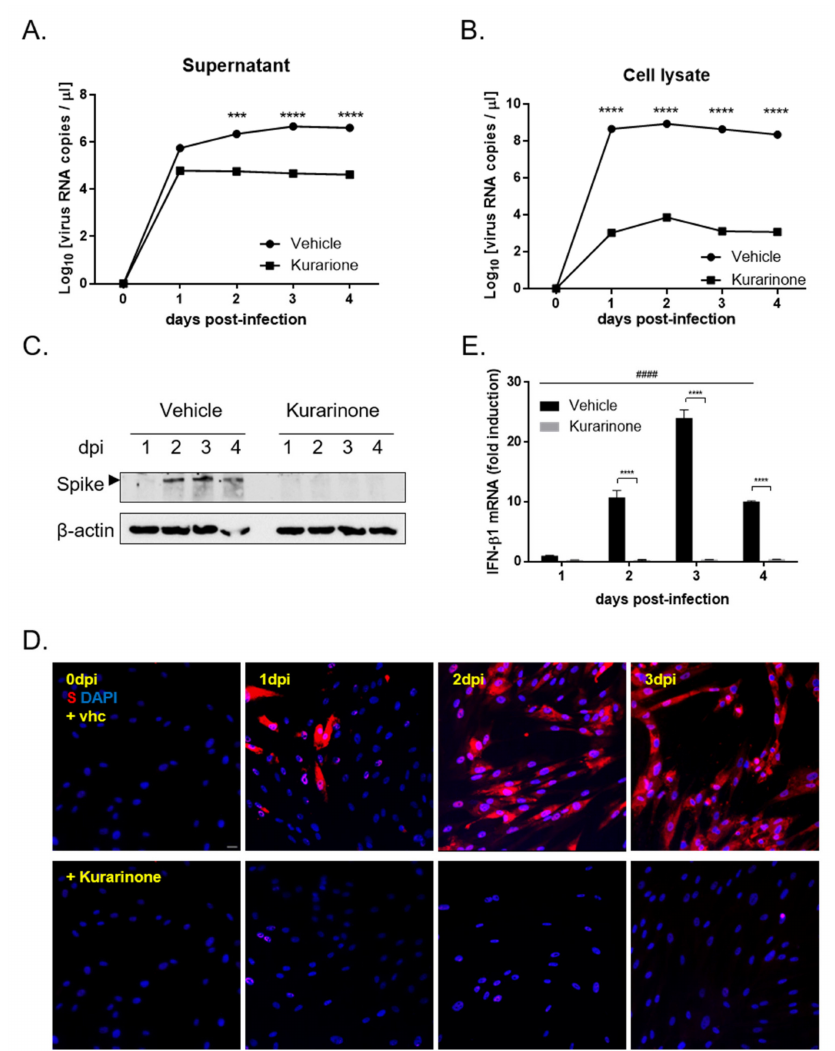
Figure 2. Detection of viral RNA and virus Spike protein in cell cultures treated with kurarinone. Viral RNA was purified from ( A ) culture supernatants or ( B ) cell lysates for quantification of HCoV-OC43 virus replication. RNA copy numbers were measured by qRT-PCR; ( C ) Western blot of the lysates of HCoV-OC43-infected MRC-5 cells treated with kurarinone or vehicle and evaluated at 1, 2, 3, and 4 dpi. The HCoV-OC43 Spike protein was detected and indicated by an arrowhead as shown; β -actin was used as a loading control. ( D ) Immunofluorescence analysis of HCoV-OC43-infected MRC-5 cells treated with vehicle (vhc) or kurarinone; cells were probed with an anti-viral Spike protein-specific antibody (red) and mounted with DAPI (blue) at 0, 1, 2, and 3 dpi. Scale bar is 50 µ m. ( E ) Quantification of mRNA encoding interferon (IFN)- β 1 by qRT-PCR in vehicle and kurarinone-treated MRC-5 cells; probes targeting the β -actin gene were used for data normalization. Data were presented as means ± SEM of three independent experiments, and analyzed by two-way ANOVA with Bonferroni’s multiple comparisons test. In (A), treatment e ff ect, F(1, 8) = 218.7; dpi e ff ect, F(4, 8) = 36.31; treatment × dpi interaction, F(4, 8) = 36.1; in (B), treatment e ff ect, F(1, 8) = 2766; dpi e ff ect, F(4, 8) = 338.5; treatment × dpi interaction, F(4, 8) = 338.5; *** p < 0.001, **** p < 0.0001 versus vehicle-treated group; in (E), treatment e ff ect, F(1, 8) = 617.4; dpi e ff ect, F(3, 8) = 112.7; treatment × dpi interaction, F(3, 8) = 112.0; **** p < 0.0001 versus virus-infected and vehicle-treated group, #### p < 0.0001 versus virus-infected vehicle-treated group at 1